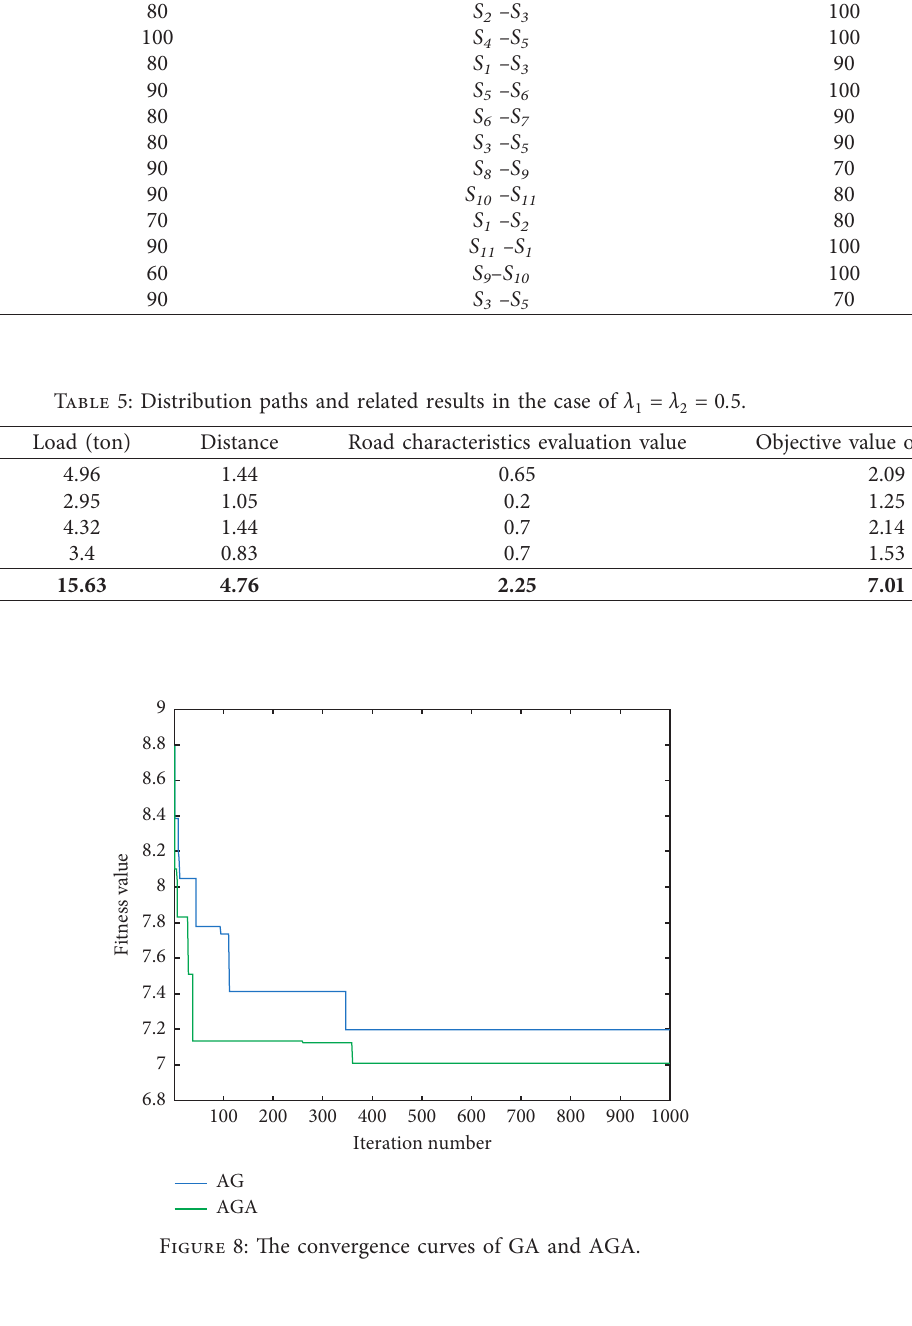
Table 6: Distribution paths and related results in the case of λ